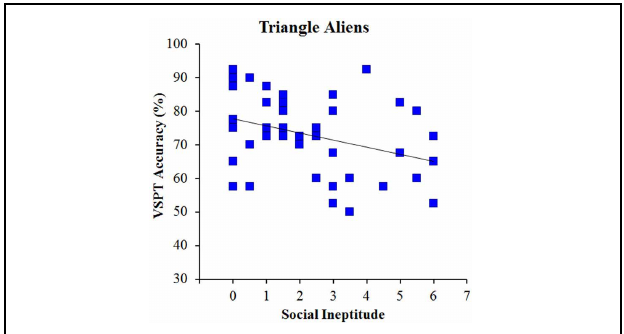
FIGURE 7 | VSPT performance as a function of social ineptitude score for the triangle aliens